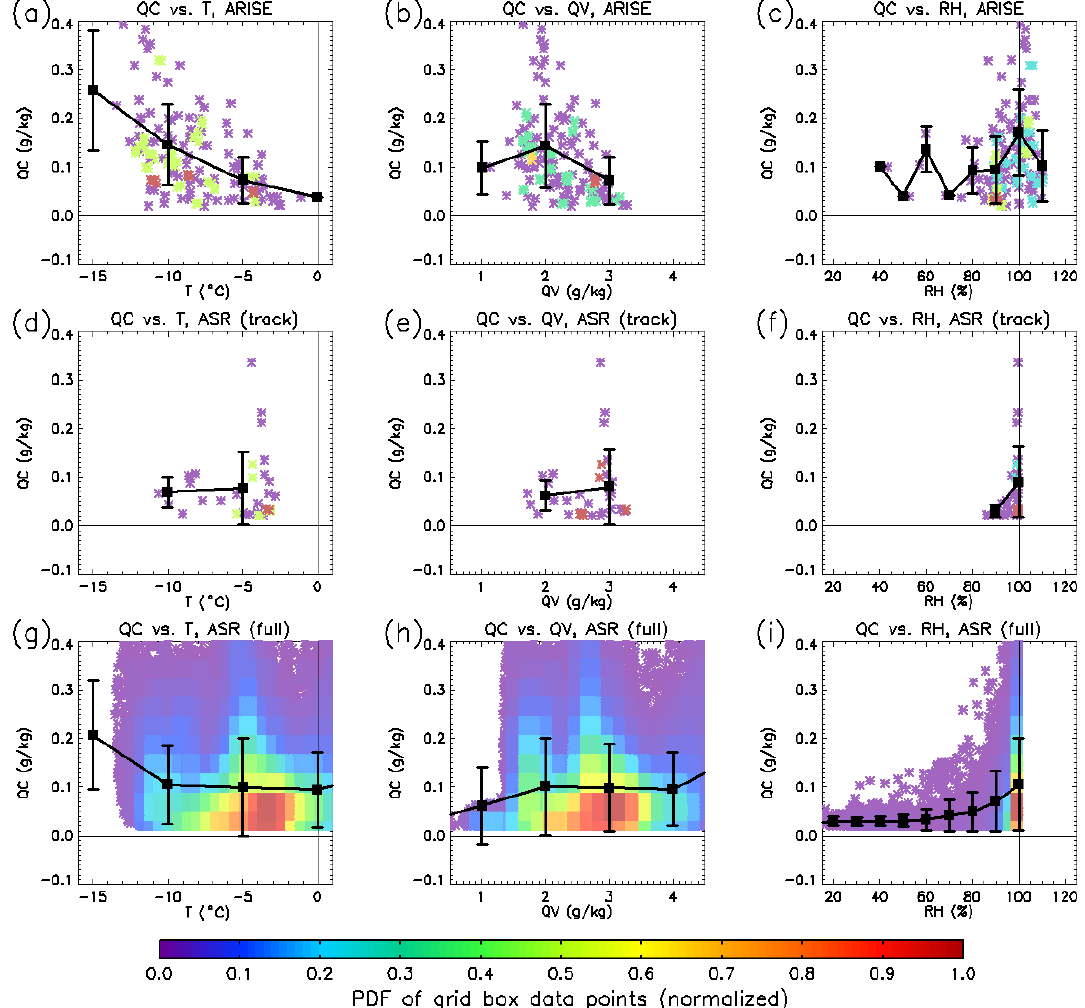
Figure 7. Same as Fig. 6, but for cloudy grid